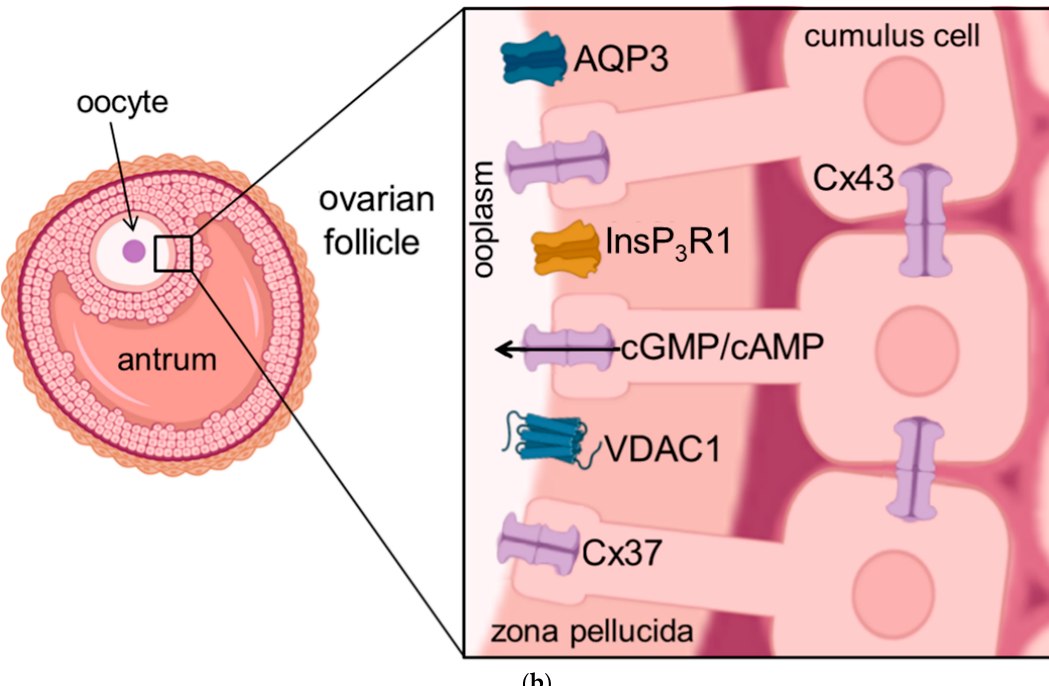
Figure 1. Schematic illustration of the cellular location of aquaporins and related proteins. ( a ) shows the localization and function of aquaporins and related proteins; ( b ) shows the localization of aquaporin and related proteins in the oocyte-cumulus-complex. Abbreviations: AQP—aquaporin;